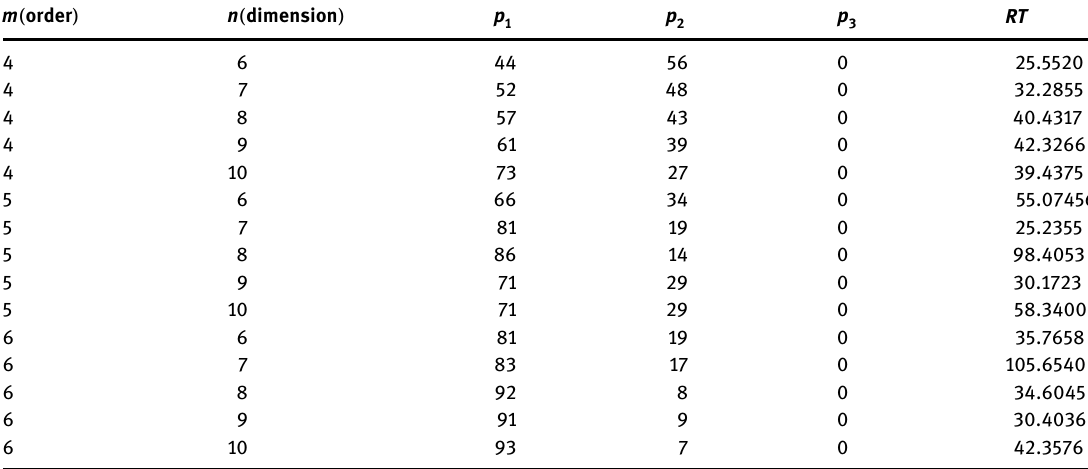
Table 1: Numerical results of Example